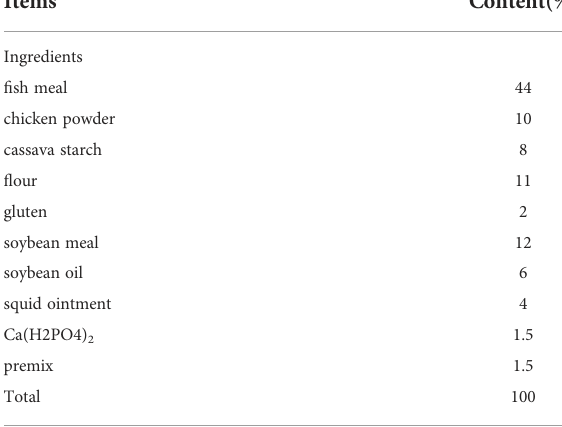
TABLE 1 Composition and nutrient levels of the basal diet (air-dry basis). Items